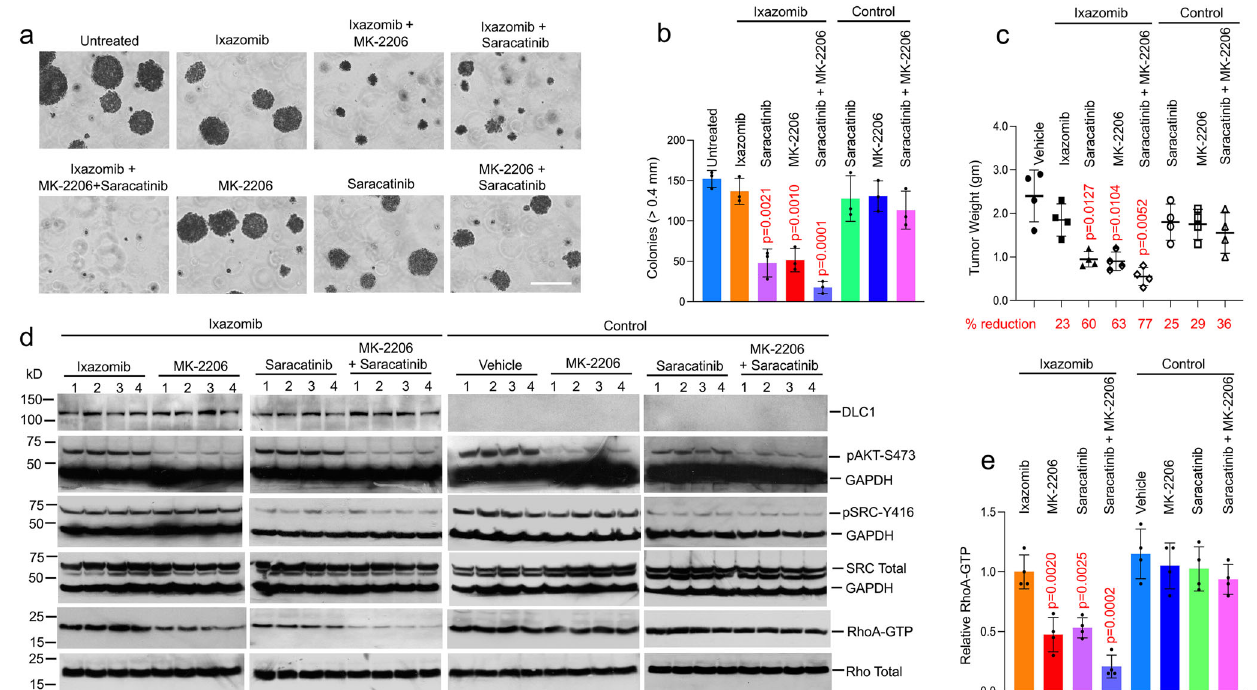
Fig. 2 Saracatinib and MK-2206 cooperate with Ixazomib in reducing anchorage-independent and tumor xenograft growth. a , b Anchorage- independent growth of A549 cells treated with Ixazomib, MK-2206, and/or Saracatinib for 3 weeks. a In the presence of Ixazomib, MK-2206, or Saracatinib treatment inhibited colony formation in soft agar. Bar, 2 mm. b Quanti fi cation of agar colonies in a (>0.4 mm). For each treatment group, mean and standard deviation (SD) are shown. N = 3 independent experiments. Error bars represent SD. The combined treatment of MK-2206 and/or Saracatinib together with Ixazomib induced a signi fi cant decrease in colony number. However, the decrease was not signi fi cant with MK-2206 and/or Saracatinib treatment alone or Ixazomib alone. For the statistical analysis, a parametric unpaired t -test with Welch ’ s correction was performed for b , c , and e using Prism software. The statistical test was two-sided, and no adjustments were made for multiple comparisons. p = 0.0021 for untreated versus Ixazomib + Saracatinib, p = 0.0010 for untreated versus Ixazomib + MK-2206, and p = 0.0001 for untreated versus Ixazomib + Saracatinib + MK-2206 treatment, respectively. ( c – e ) Response of mouse A549 xenograft tumors to treatment with Ixazomib (3 weeks) and MK-2206 and/or Saracatinib (2 weeks). c For each treatment group, individual tumor weights, mean, and SD are shown. Error bars represent SD. The numbers at the bottom represent the percent reduction for each treatment group compared with the untreated vehicle control. N = 4 mice per group. p = 0.0127 for vehicle versus Ixazomib + Saracatinib, p = 0.0104 for vehicle versus Ixazomib + MK-2206, and p = 0.0052 for vehicle versus Ixazomib + Saracatinib + MK-2206 treatment, respectively. d MK-2206 or Saracatinib treatment of tumors ef fi ciently inhibited AKT (pAKT-S473) and SRC (pSRC-Y416) activities, but only reduced RhoA-GTP when treated with Ixazomib (Ixazomib treatment group, fi rst and second panels), and not in DLC1-negative (control, third and fourth panels). Treatment with all three drugs reduced RhoA-GTP to a greater degree than two drugs. e Graph shows mean RhoA-GTP ± SD within each group. Error bars represent SD. N = 4 mice tumors. p = 0.0020 for vehicle versus Ixazomib + MK-2206, p = 0.0025 for vehicle versus Ixazomib + Saracatinib, and p = 0.0002 for vehicle versus Ixazomib + MK-2206 + Saracatinib treatment, respectively. Source data are provided as a Source Data fi